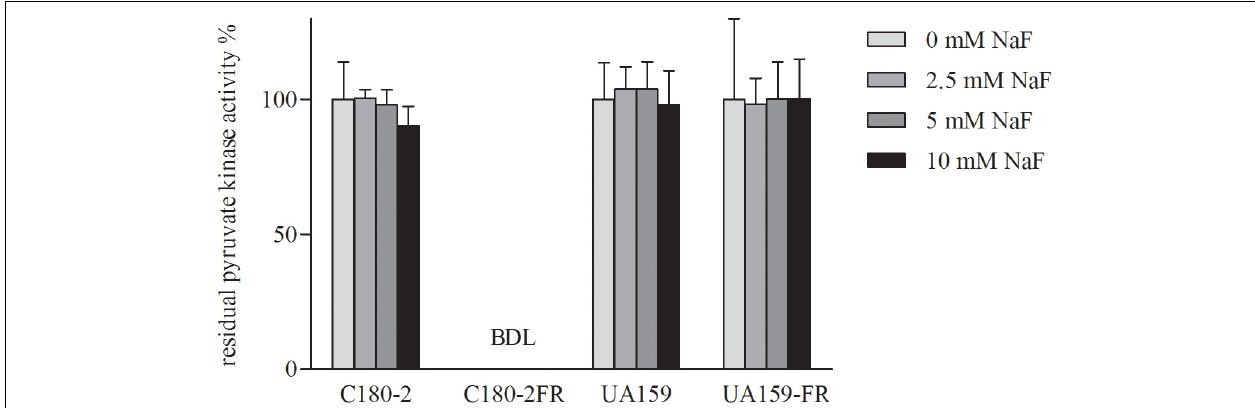
FIGURE 4 | Residual activity of pyruvate kinase in S. mutans C180-2, C180-2FR, UA159, and UA159-FR after incubation with different concentrations of NaF. The activity of the control group which was incubated without NaF was set at 100%. BDL, below detection limit.